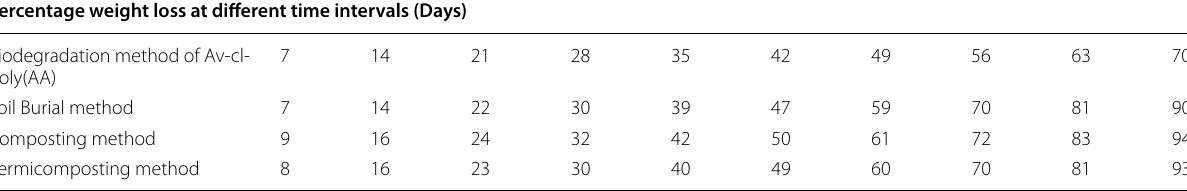
Table 1 Biodegradation study of synthesized Av-cl-poly(AA) through soil burial, composting and vermicomposting method Percentage weight loss at different time intervals